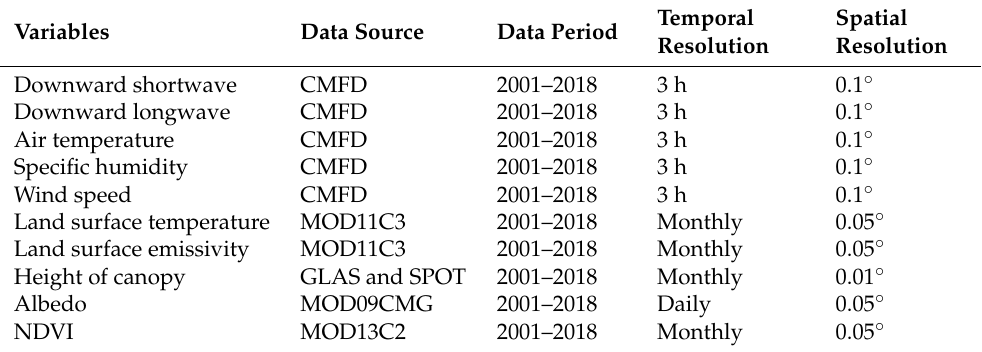
Table 3. Input datasets for the SEBS model. MOD11C3 is the short name of the MODIS/Terra land surface temperature and emissivity monthly L3 global products, MOD09CMG is the short name of the MODIS/Terra surface reflectance daily L3 global products, MOD13C2 is the short name of the MODIS/Terra vegetation indices’ monthly L3 global products, GLAS stands for the Geoscience Laser Altimeter System, and SPOT stands for the Systeme pour l’Observation de la Terre sensor. Variables Data Source Data Period